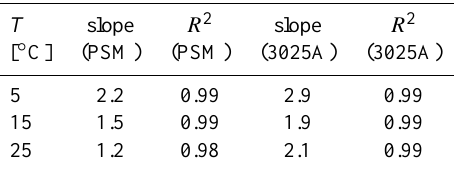
Table 4. The slopes ( d lnJ/ d ln [H 2 SO 4 ]) of fits to data in Fig. 2 at three different temperatures (5, 15 and 25 ◦ C) and relative humidity ∼ 50%.